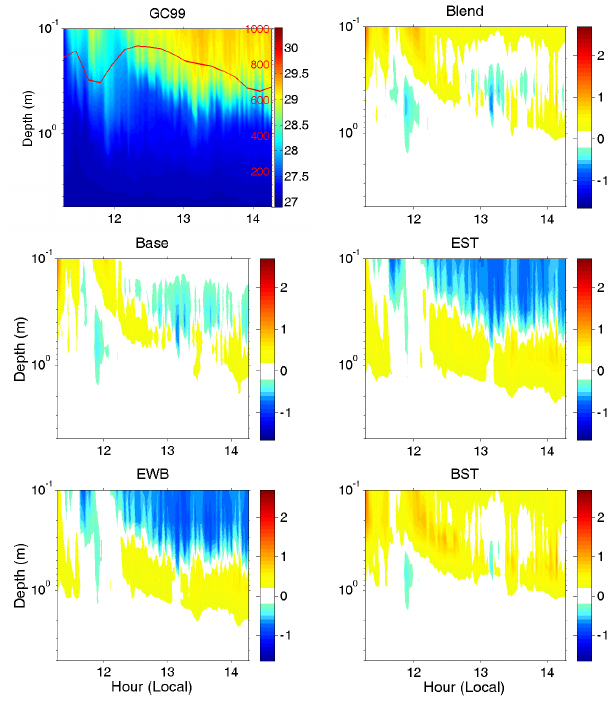
Fig. 3 : Time-series temperature depth plots for GC99 case study: observational plot and temper- Fig. 3. Time-series temperature depth plots for the GC99 case study: ature difference (modeled minus observed) plots for the 5 model versions. Red curve represents observational plot and temperature difference (modelled minus ob- served) plots for the five model versions. Red curve represents ob- observed solar irradiance (Wm − 2 ). The white area used represents an ideal ∆ T T of ± 0.2 K. served solar irradiance (Wm − 2 ). The white area used represents an ideal 1T of ±